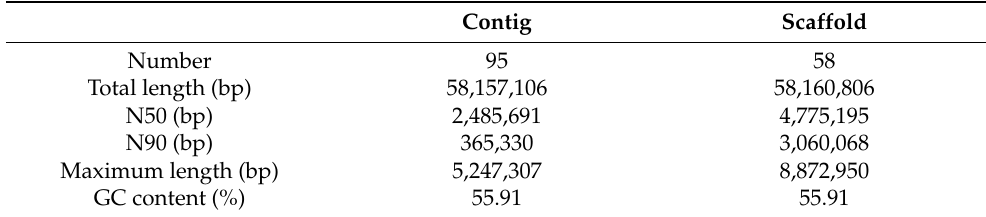
Table 1. Statistics for genome